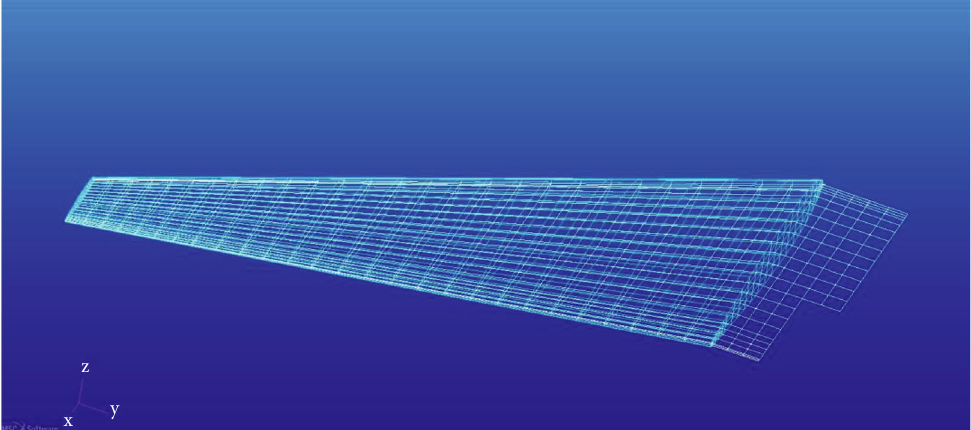
Figure 4: The structure fi nite element model of the wing.